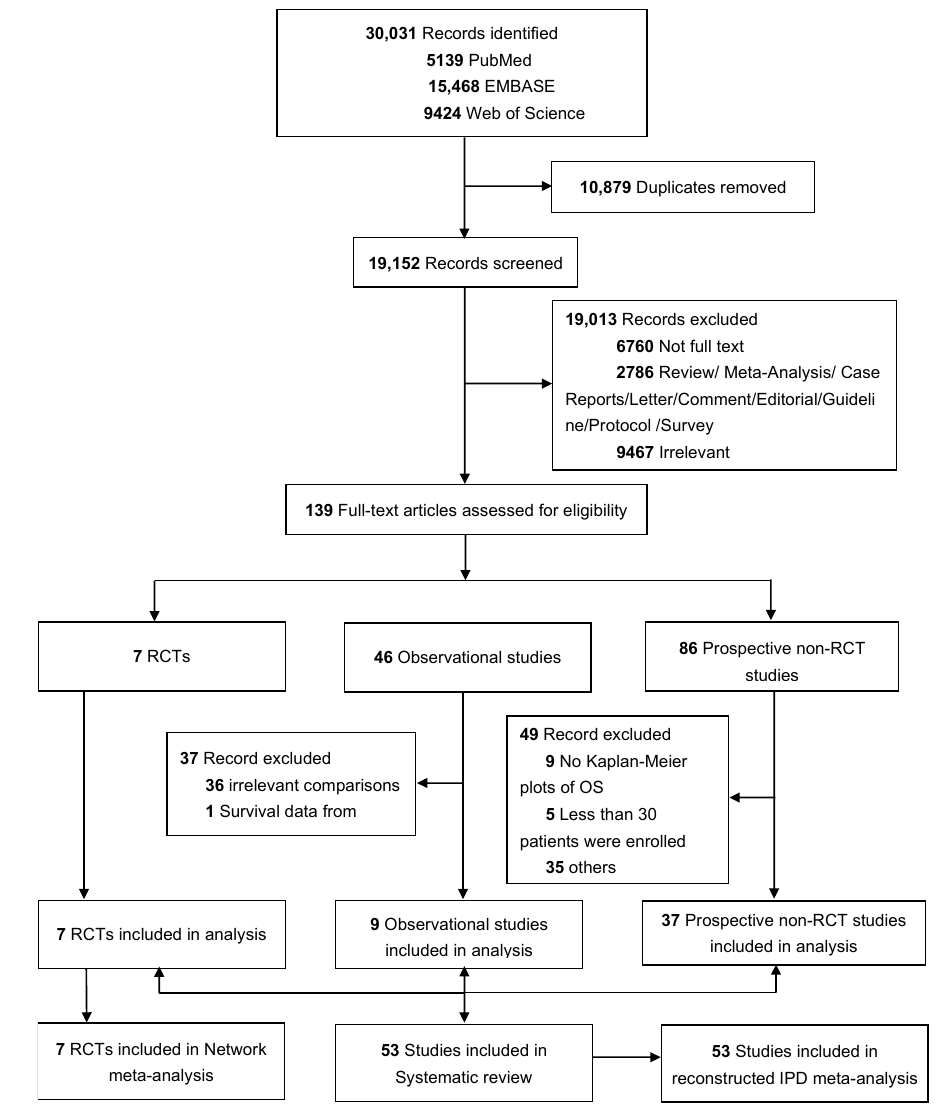
Figure 1. Study selection. Abbreviations: RCT, randomized controlled trials; OS, overall survival; NCDB, National Cancer Database; IPD, individual patient data.